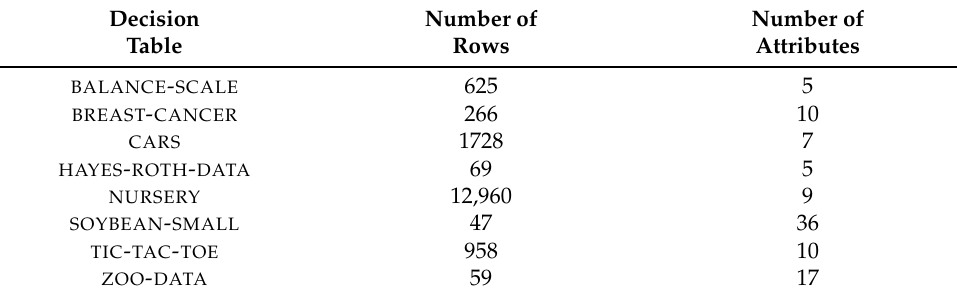
Table 1. Decision tables from Reference [20] used in experiments.